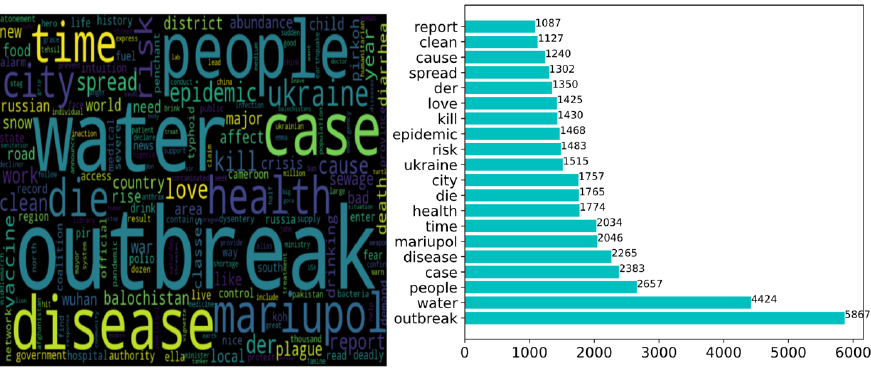
Figure 5. Word cloud and bar plot for